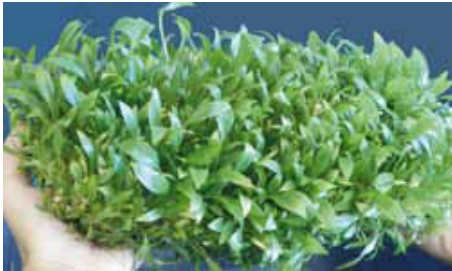
Figure 18: Micropropagation protocol development of multi-functional phyto-bioreactor on Hosta sp. model plant